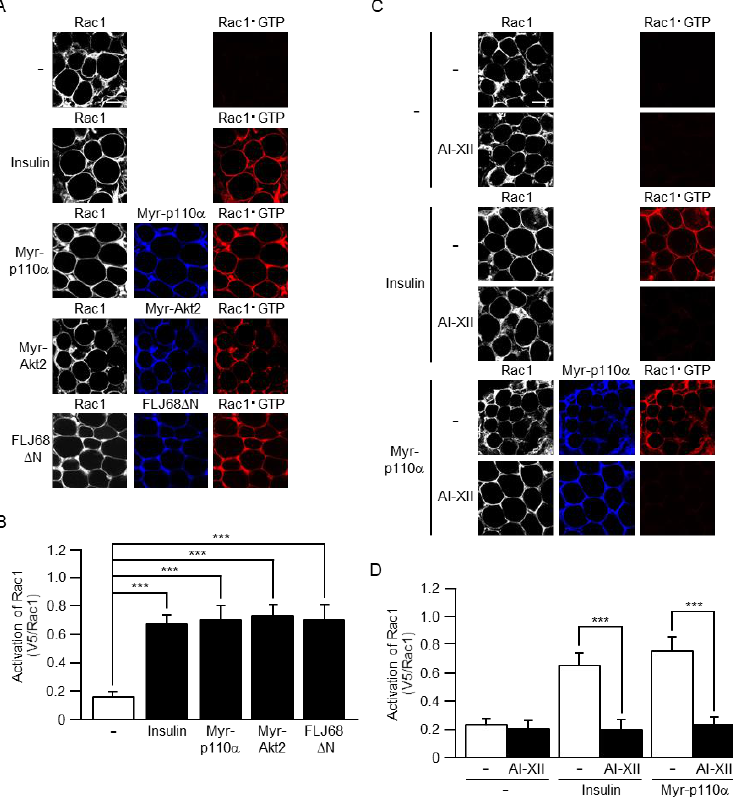
Figure 5. The activation of Rac1 by insulin or a constitutively activated mutant of PI3K, Akt2, or FLJ00068 and the effect of an Akt2-specific inhibitor on Rac1 activation. ( A ) Endogenous Rac1 was visualized by immunofluorescent microscopy using an anti-Rac1 antibody. Myr-p110α, Myr-Akt2, and FLJ68ΔN were visualized by immunofluorescent microscopy using an anti-HA antibody. Rac1·GTP was visualized by immunofluorescent microscopy using the activation-specific probe GST-POSH(251–489)-V5×3 and an anti-V5 antibody. Scale bar, 50 μm. ( B ) The activation of Rac1 shown in ( A ) was quantified. Data are shown as means ± S.E. ( n = 15). *** P < 0.001. ( C ) Endogenous Rac1 was visualized by immunofluorescent microscopy using an anti-Rac1 antibody. Myr-p110α was visualized by immunofluorescent microscopy using an anti-HA antibody. Rac1·GTP was visualized by immunofluorescent microscopy using the activation-specific probe GST-POSH(251–489)-V5×3 and an anti-V5 antibody. In some experiments, excised sWAT was treated with AI-XII (5 µM) for 2 h. Scale bar, 50 µm. ( D ) The activation of Rac1 shown in ( C ) was quantified. Data are shown as means ± S.E. ( n = 15). *** P < 0.001.